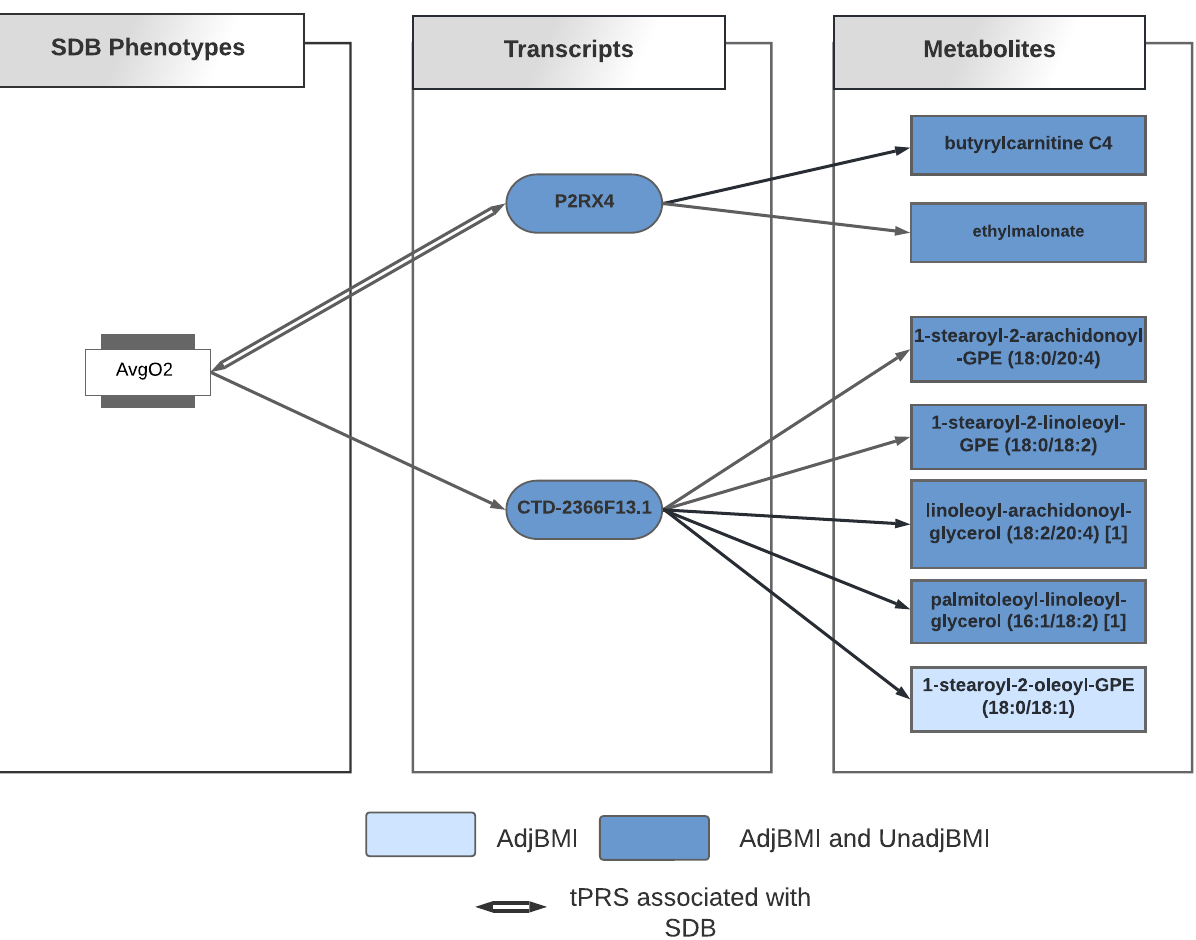
Fig. 2 Identi fi ed association chains between AvgO 2 , transcripts, and metabolites. Diagram illustrating the “ association chain ” relationships between AvgO 2 , tPRS, and metabolites in BMI-unadjusted and BMI-adjusted analyses. Dark blue color indicates association between tPRS and metabolites in both BMI-unadjusted and BMI-adjusted analyses; The light blue color indicates the association between tPRS and metabolite only in BMI-adjusted